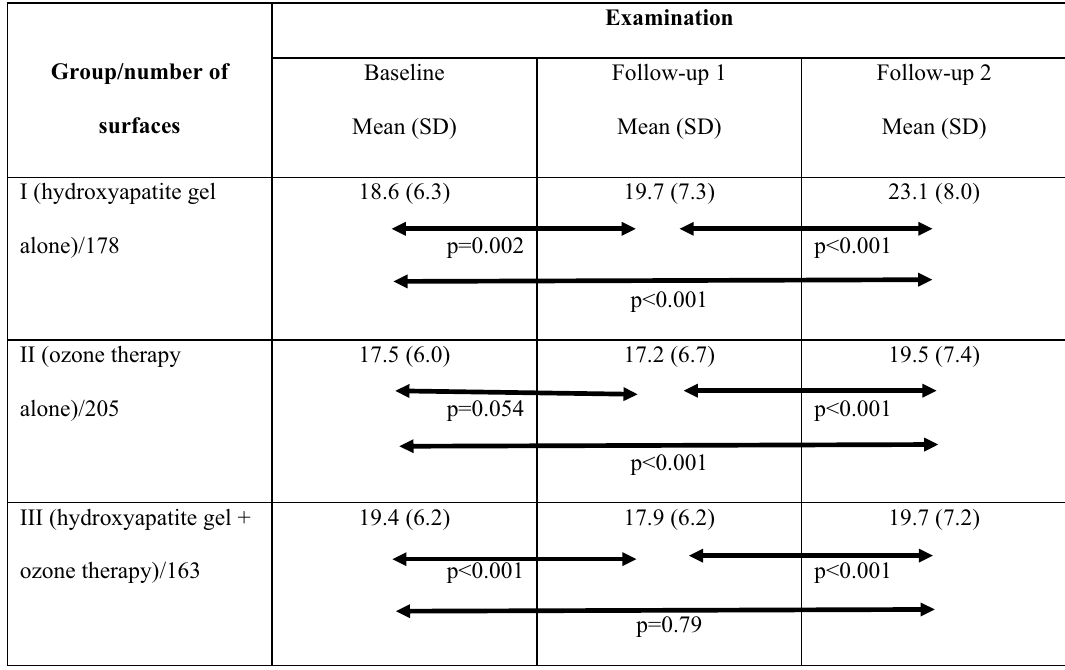
Table 2. Differences between average optical densities in the lesion area and the reference point in subsequent examinations.